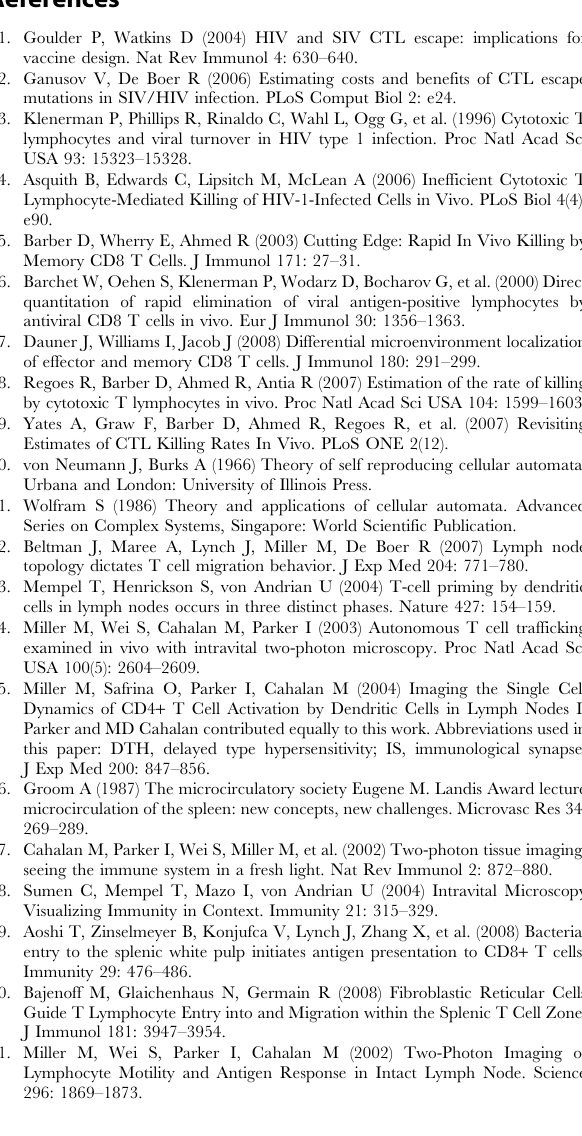
bound in conjugates are shown in lightblue and orange, respectively. The movie shows the first 100 min of a simulated time period of 300 min. The size of the full movie is too large to be